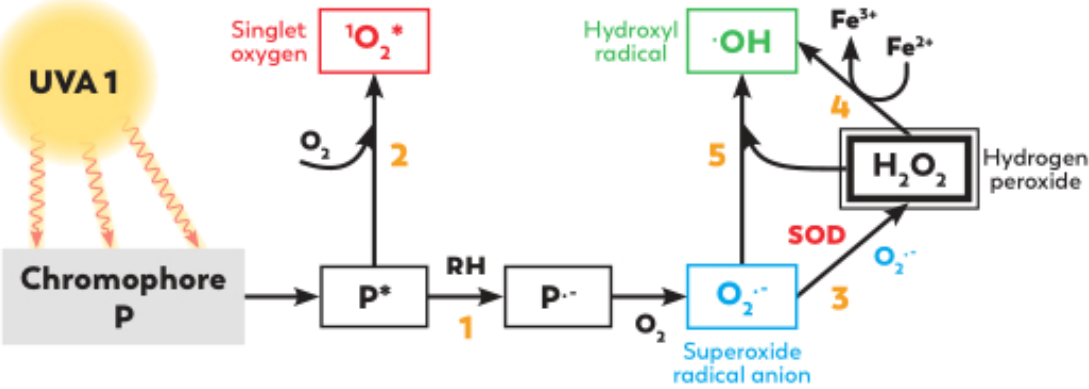
Figure 2. Simplified scheme of ROS formation after UVA exposure. Endogenous chromophore P can absorb UVA photons, leading to the formation of chromophores in photoexcited states P* such as the triplet state and initiating different reactions with molecular oxygen. In a type I reaction (1) (electron transfer), P* can react with an electron donor substrate (RH), leading to P − , which is able to react with oxygen, generating superoxide radical anion O 2 − and a cascade of reactive reduction products. The spontaneous dismutation of O 2 − leads to hydrogen peroxyde formation H 2 O 2 ; this reaction is accelerated by superoxide dismutase SOD (3). H 2 O 2 can then lead to hydroxyle radical OH . formation via Fenton (4) and Haber–Weiss (5) reactions, thanks to electron donors such as Fe 2+ or O 2 − , respectively. In a type II reaction (2) (energy transfer), the photoexcited sensitizer can react with molecular oxygen, leading to the formation of singlet oxygen ( 1 O 2 *) capable of oxidizing a sub- strate. For more details, see [27] .